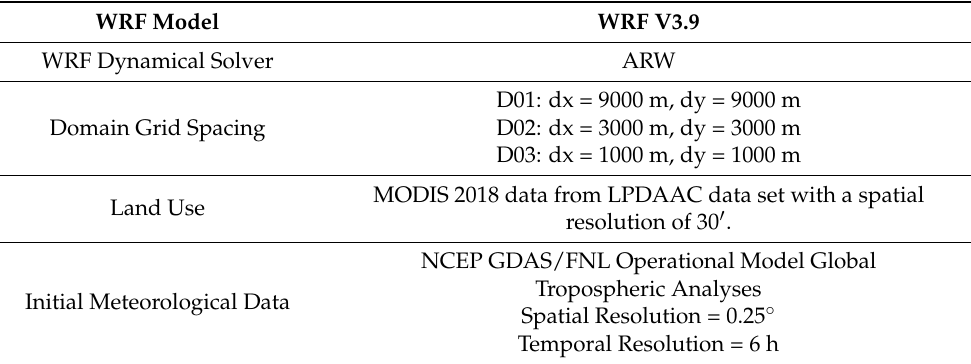
Table 2. Configurations and physical parameterizations applied in